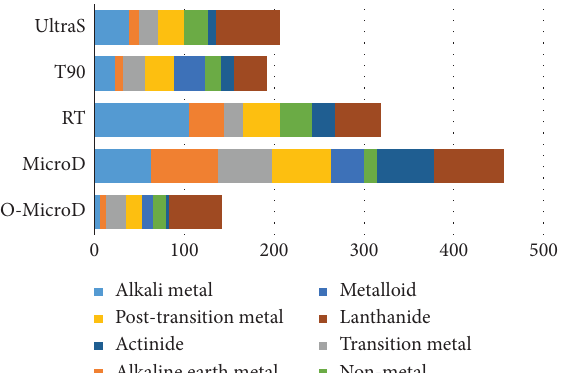
Figure 3: Te horizontal bar chart represents the cumulative coefcient of variations (%) of eight diferent metal classes across fve diferent digestion methods for human hair. Te x -axis is the total CV for all major metal classes.